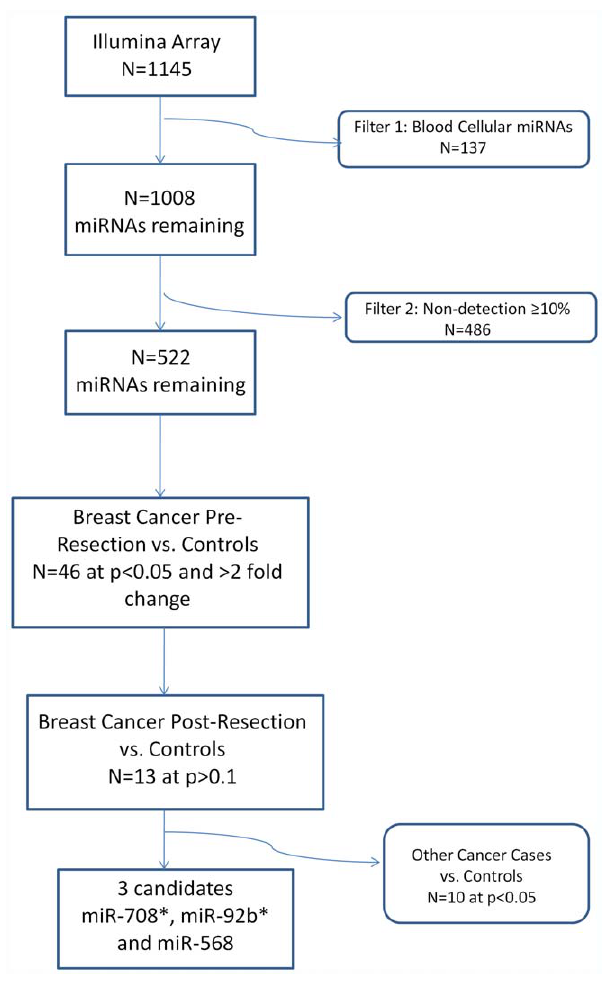
Figure 1. Summary of Study Design and Results.